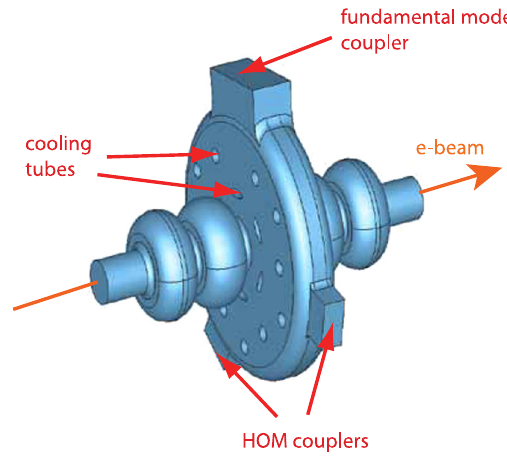
FIG. 1 (color online). A conceptual drawing of an SRF accelerator section consisting of four regular elliptical accelerat- ing cells and an accelerating PBG cell with HOM couplers.